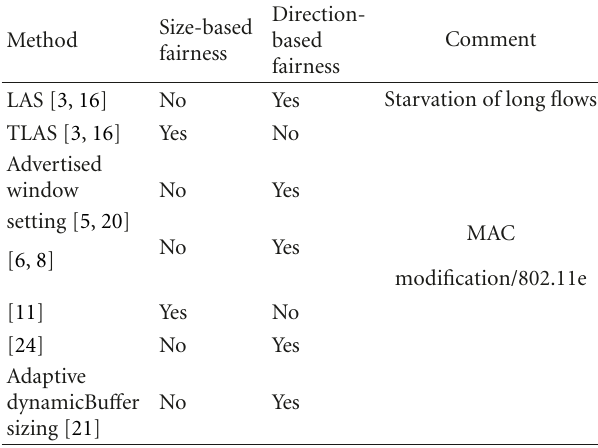
Table 1: Comparison of WLAN-oriented